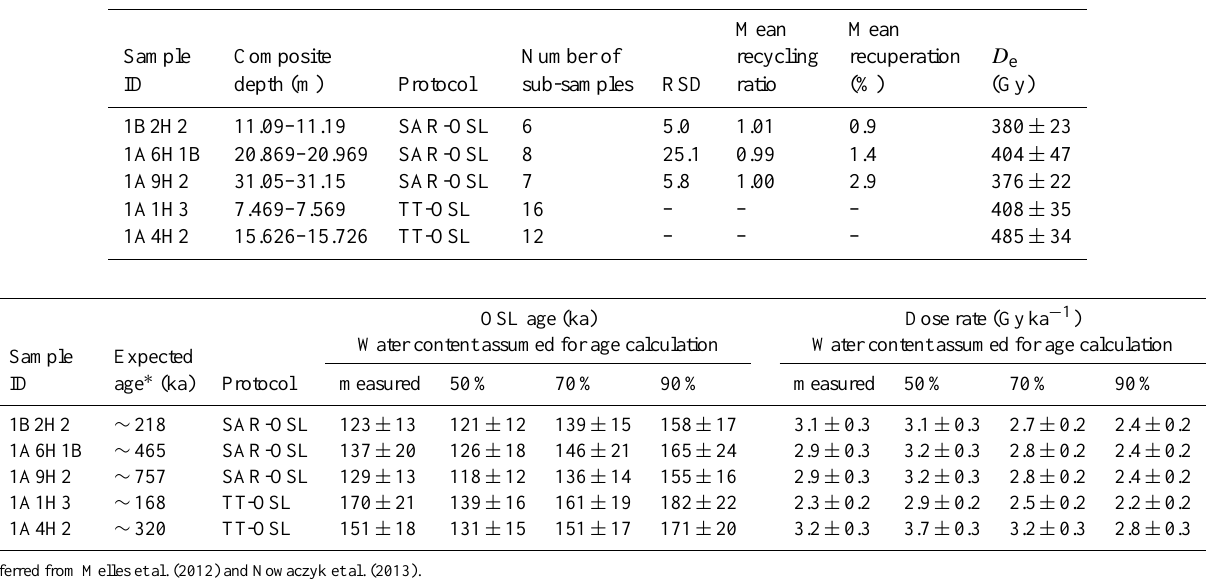
Table 3. SAR-OSL dating results and multiple aliquot regenerative dose (MAR) TT-OSL dating results obtained on fine grain quartz (4– 11µm). Ages and dose rates are given for different assumed and the measured water content (weight-%) to point out the significance of the water content on the age estimates. All analytical results are presented with their 1-sigma error.